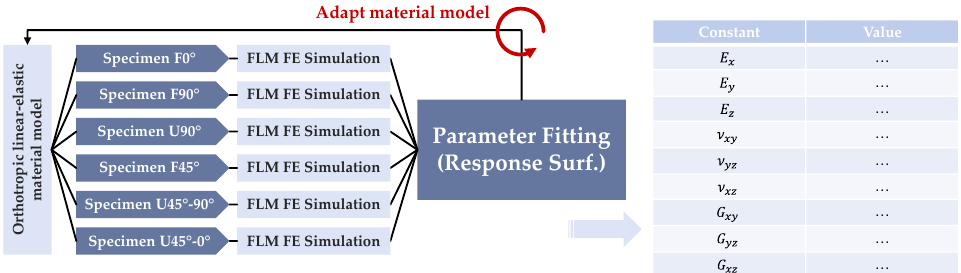
Figure 6. Fitting method in detail: F = flat, U = upright specimen as in Figure 3.